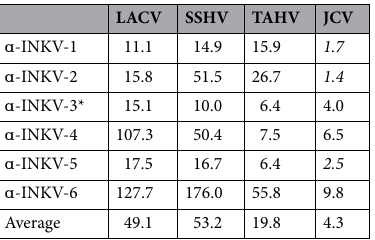
Table 7. ND50 fold difference of ɑ -INKV plasma between heterologous viruses vs. homologous INKV